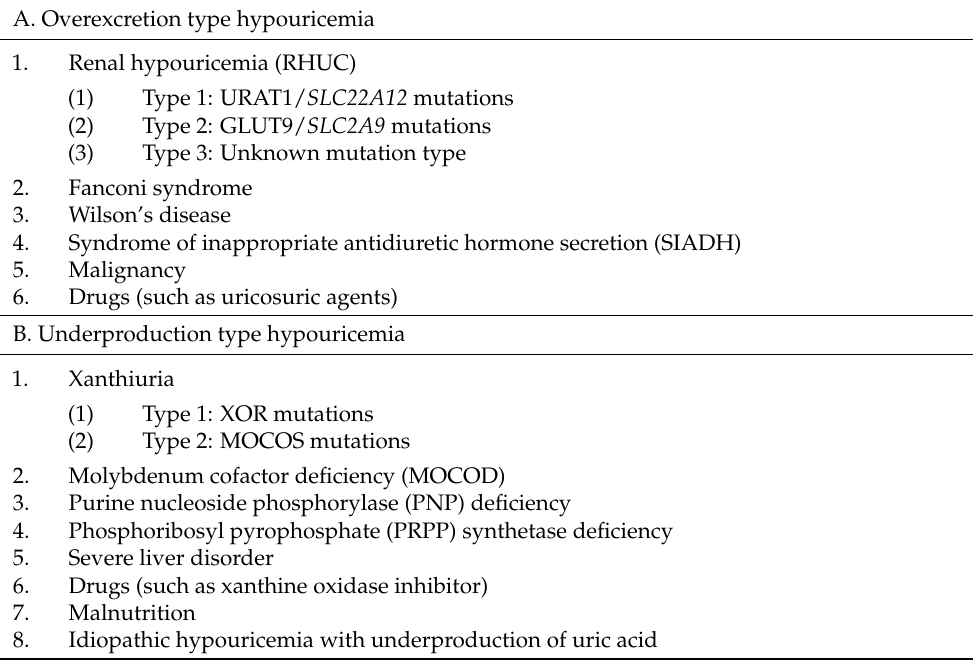
Table 1. Diseases that cause